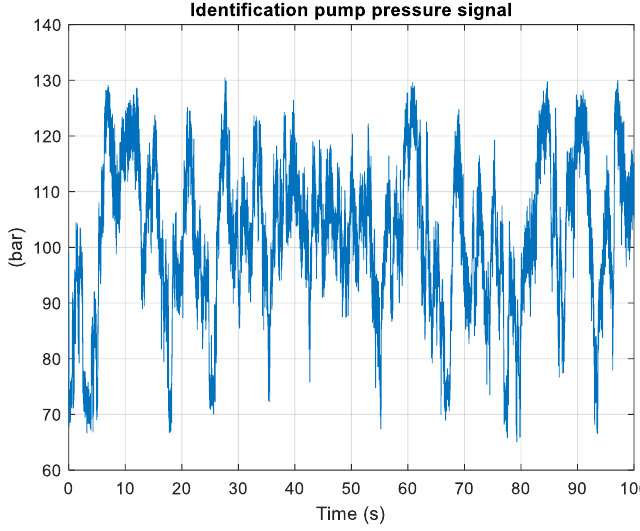
Figure 7. Pump pressure signal used for identification experiment.